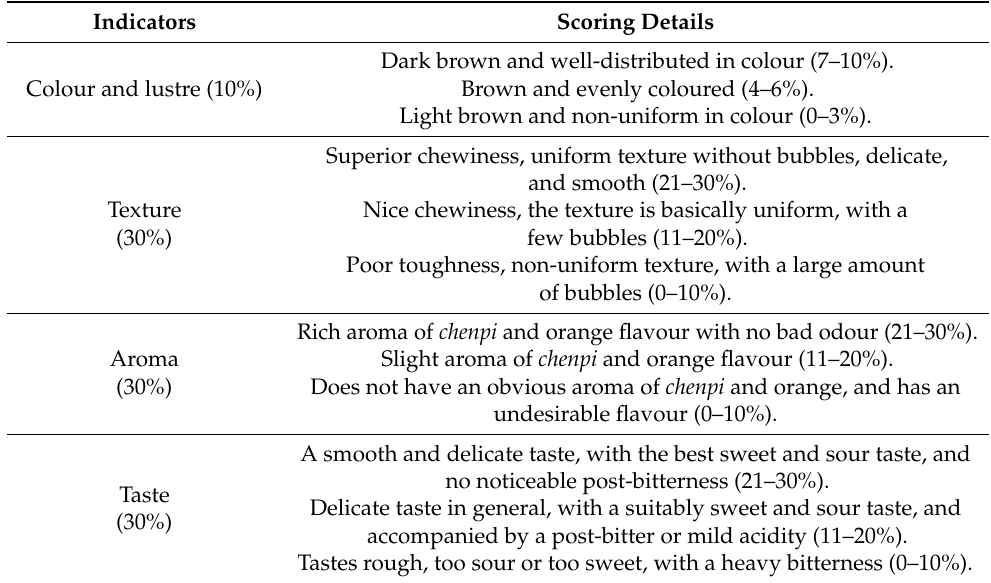
Table 1. The evaluation criterion of the